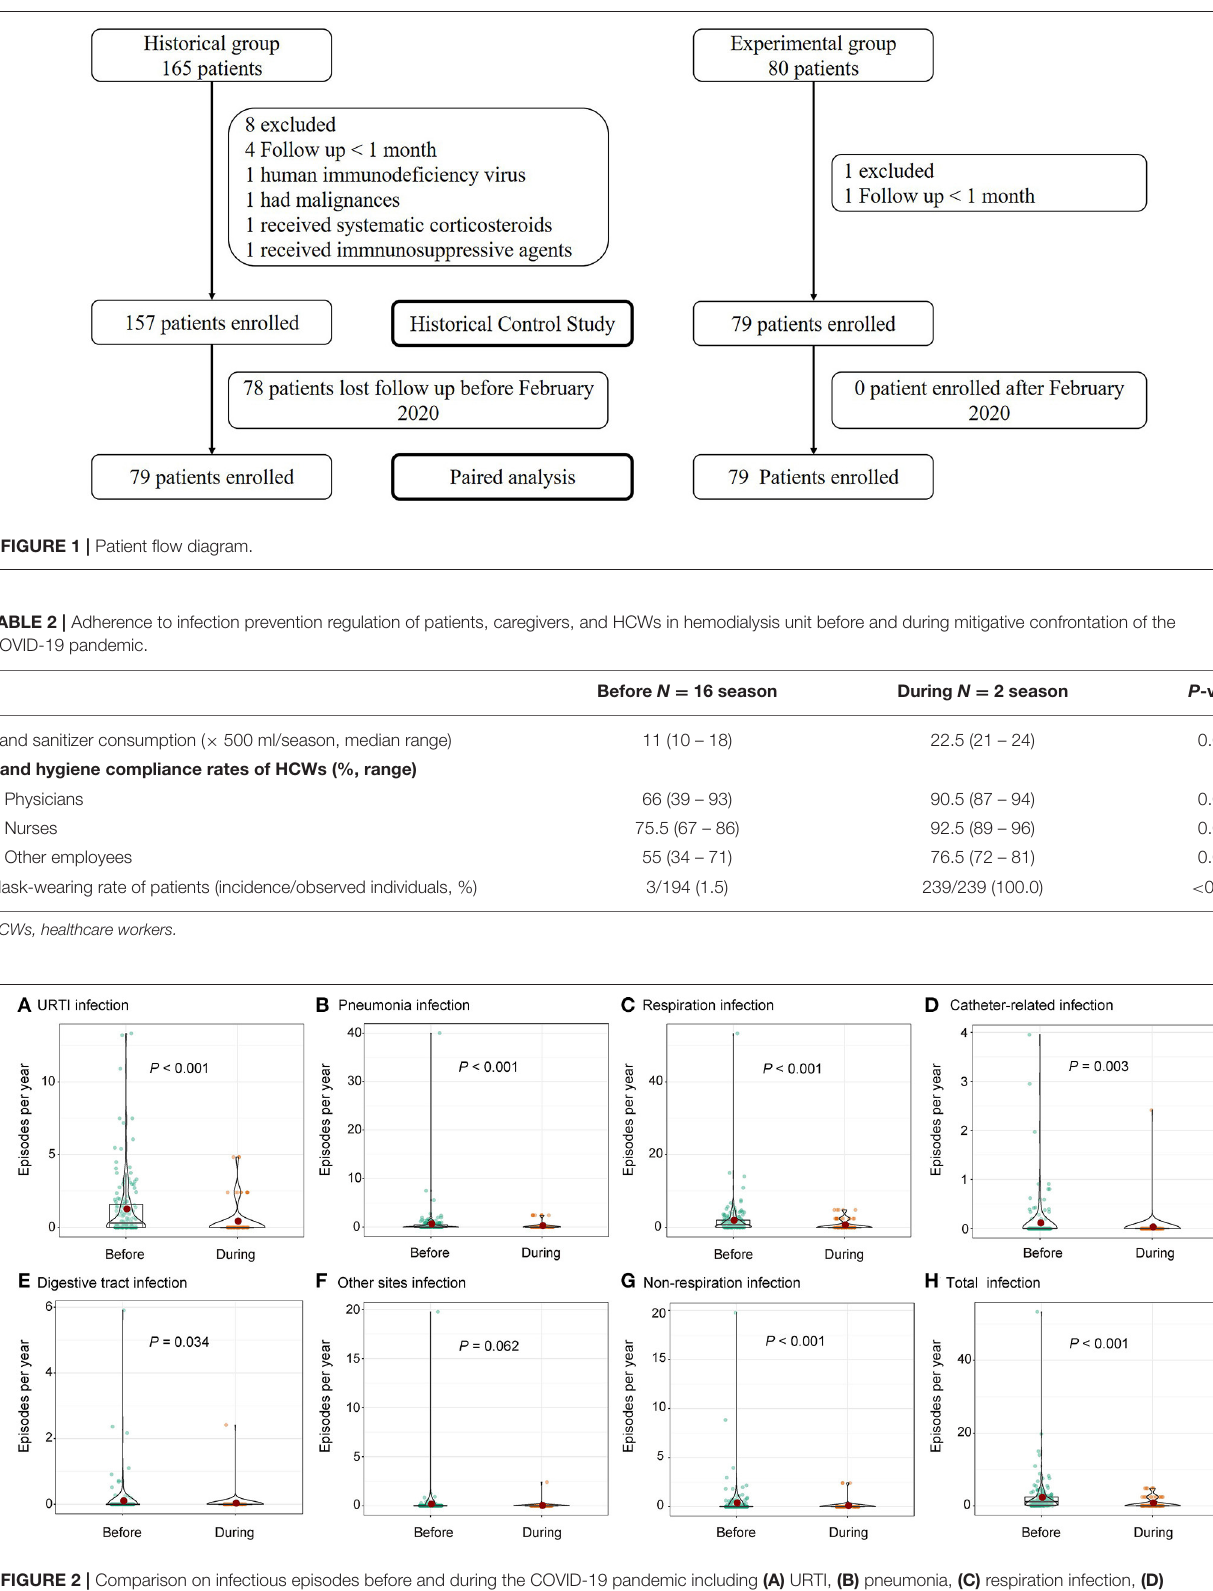
FIGURE 2 | Comparison on infectious episodes before and during the COVID-19 pandemic including (A) URTI, (B) pneumonia, (C) respiration infection, (D) catheter-related infection, (E) digestive tract infection, (F) other sites infection, (G) non-respiration infection, and (H) total infection. URTI, upper respiratory tract